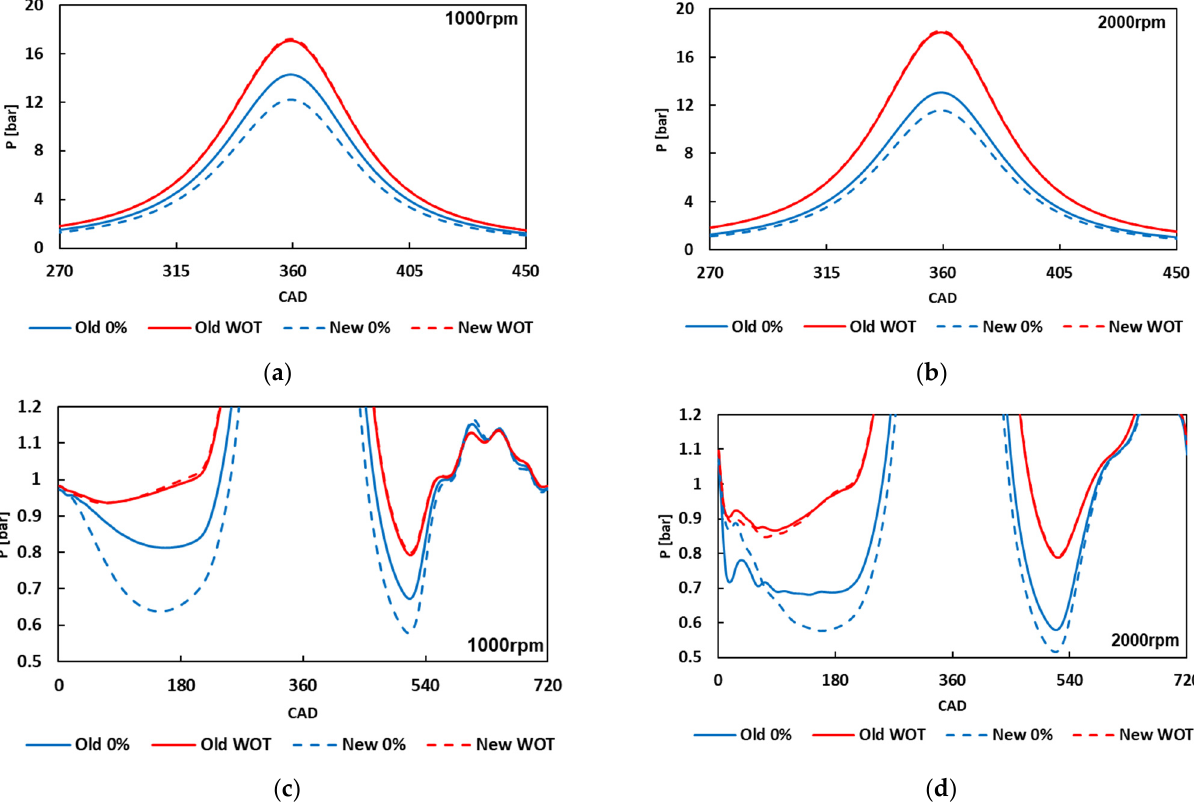
Figure 7. In-cylinder pressure traces at 1000 ( a and c ) and 2000 rpm ( b and d ) for the old (solid lines) and new (dashed lines) intake manifold design.